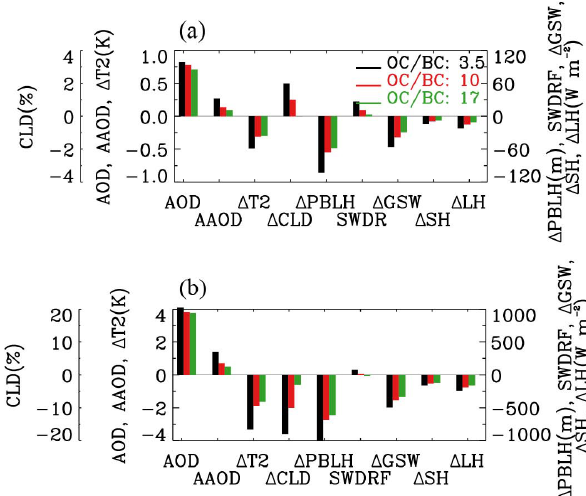
Fig. 9. (a) Monthly and domain averages over the smoke source region simulated with different OC/BC ratios in October of 2006 for AOD and AAOD, as well as the change of T 2, CLD, PBLH, SWDRF, GSW, SH, and LH due to the consideration of smoke ra- diative effect. The change of each variable is defined as the differ- ence between the simulation with and without the smoke aerosol radiative interaction ( 1V = V Ra − V non-Ra ) . (b) same as (a) but for hourly averages of the daytime (08:00–17:00LT) on 31 Octo- ber 2006. (In the case of OC/BC as 3.5, 10 and 17, respectively).